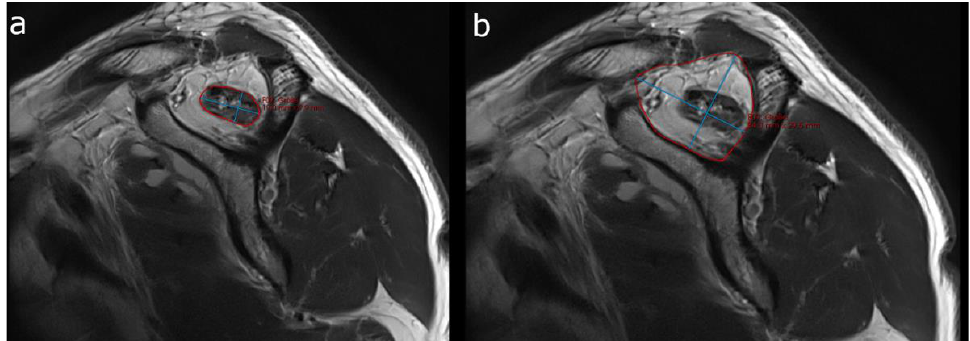
Figure 3. Sample case demonstrating semiautomated OR-value measurements. ( a ) Margins of the SSP muscle belly and ( b ) the supraspinatus fossa are manually traced (red outline) on the Y-view (oblique-sagittal T2-weighted sequence), and automated 2D measurements (largest long axis dimension and